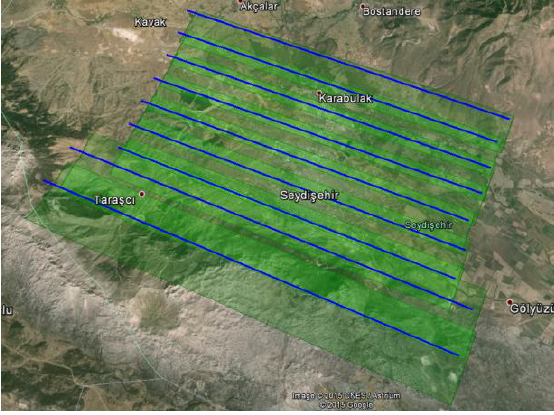
Fig.2 The Test area and the Flight columns